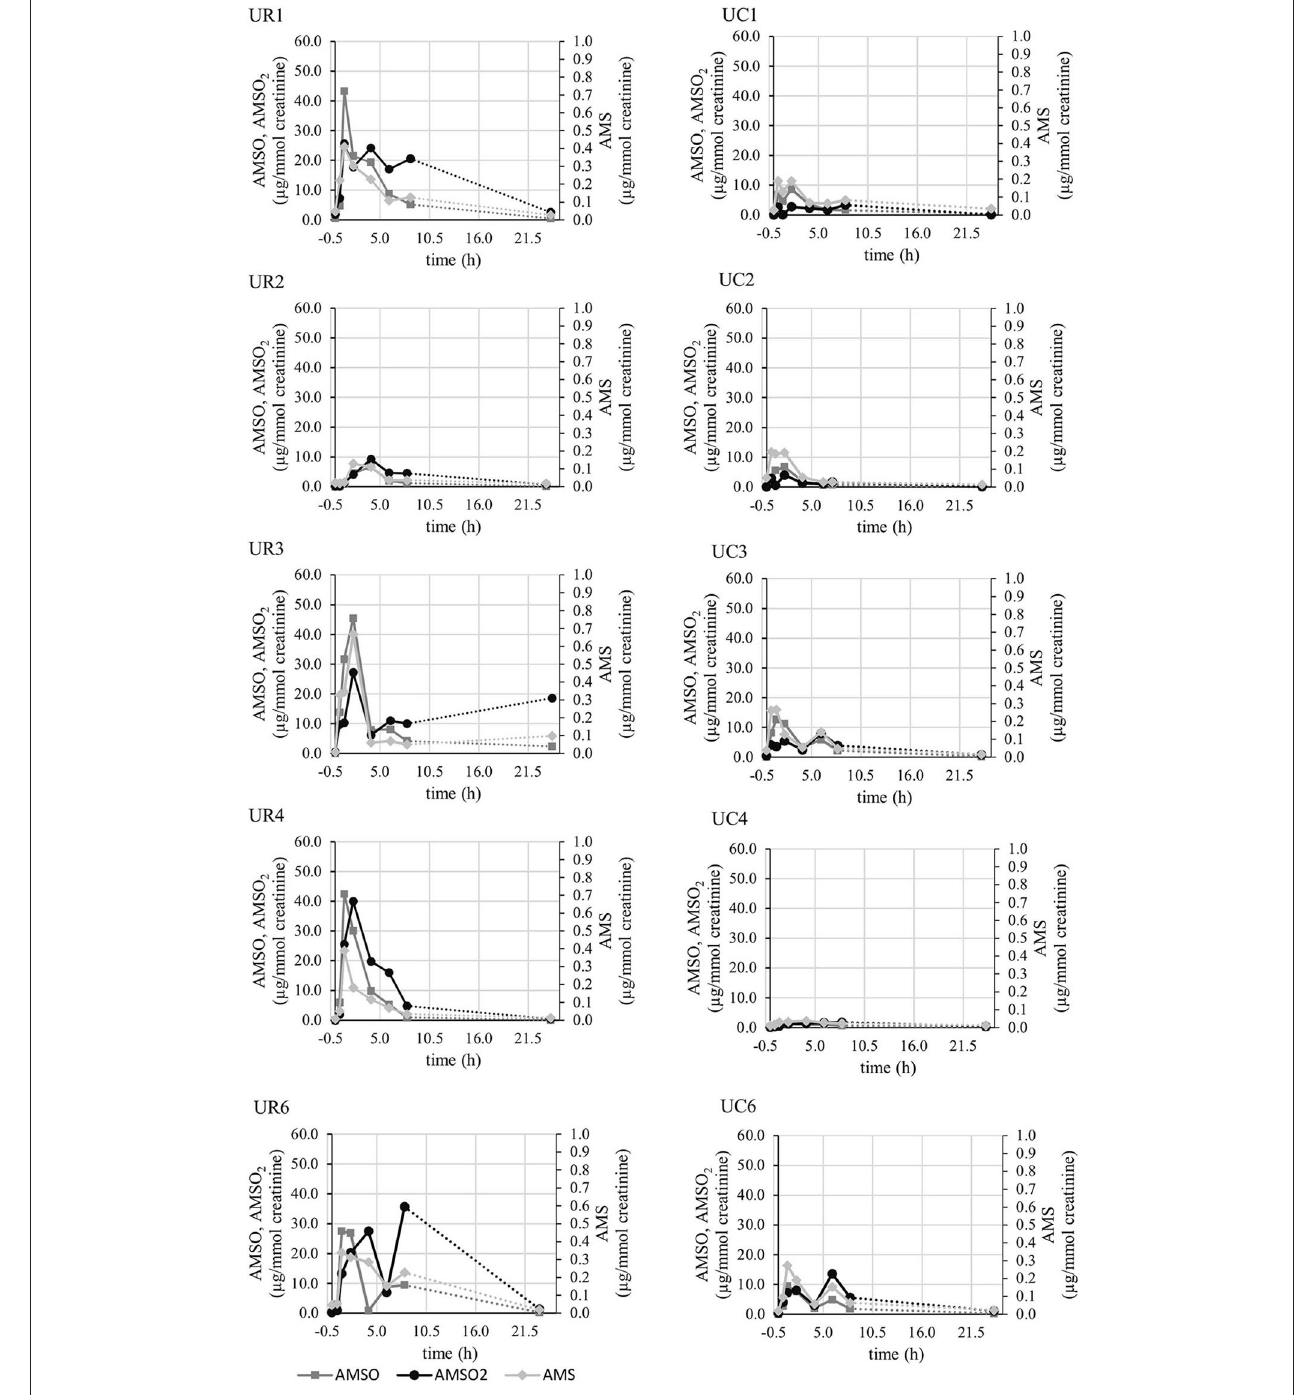
FIGURE 3 | Concentrations (in µ g/mmol creatinine) of garlic metabolites AMS (light gray line), AMSO (gray line), and AMSO 2 (black line) detected in urine collected before and after ingestion of roasted garlic (left side, “UR”) or cooked garlic (right side, “UC”) in the 5 participants taking part in both